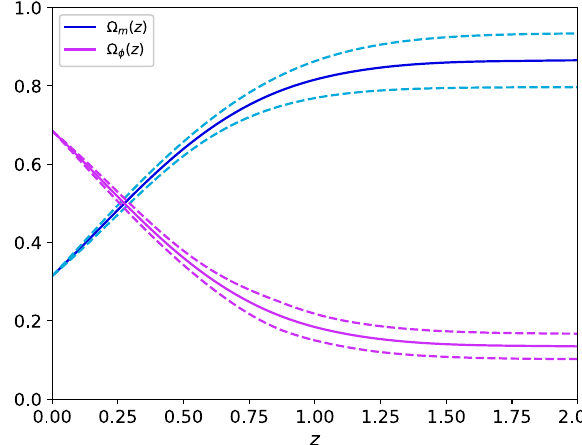
Fig. 4 The matter and DE density parameter of the Universe using the joint analysis mean values. The dashed regions show the 1 σ